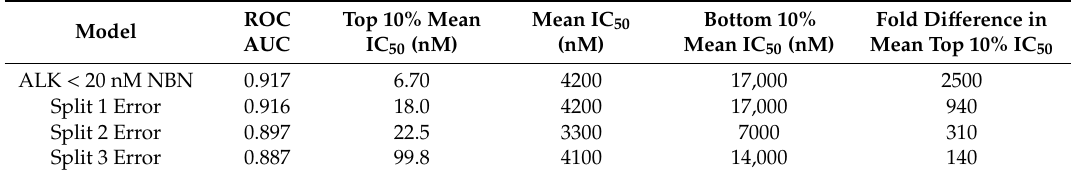
Table 11. Performance statistics for NBNs with retained predictivity generated with 27% classification error in molecules between 109 nM and 3.7 nM.